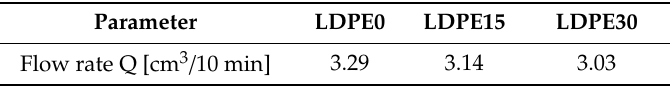
Table 4. Flow rate (Q) values obtained for tested composite